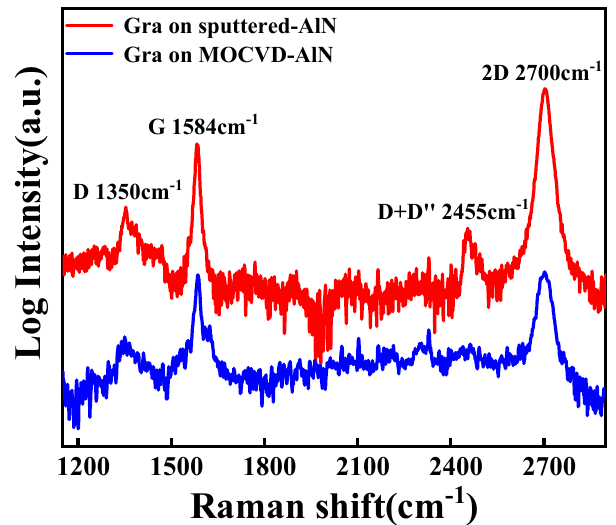
Figure 2. Raman spectra of graphene transferred on the sputtered AlN layer (red line) and MOCVD AlN (blue line) layer in the high-wavenumber region of 1200–2800 cm − 1 . The D, G, and 2D peak positions of graphene are indicated.